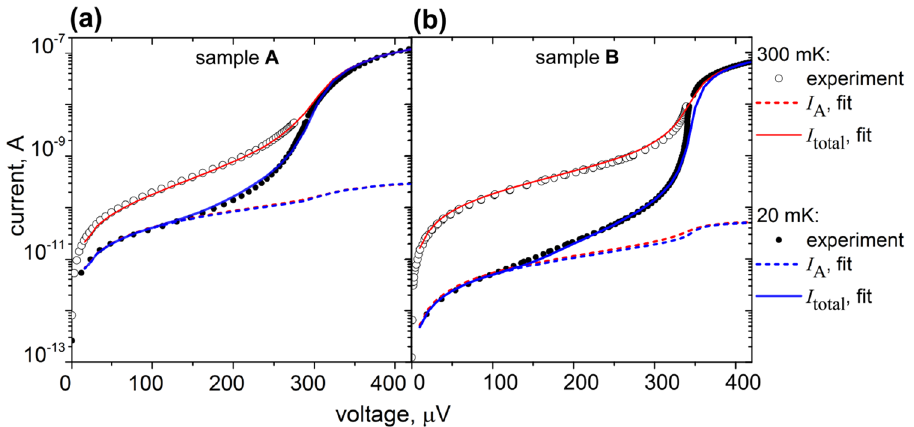
Figure 5. The fitting of IV-curves by HBE with Andreev current. ( a ) The sample A . ( b ) The sample B . The color legend from the right is valid for both ( a , b ) blue color is for 20 mK, red color is for 300 mK, dots are an experiment, solid curves are the total fitted current, the dashed curve shows Andreev